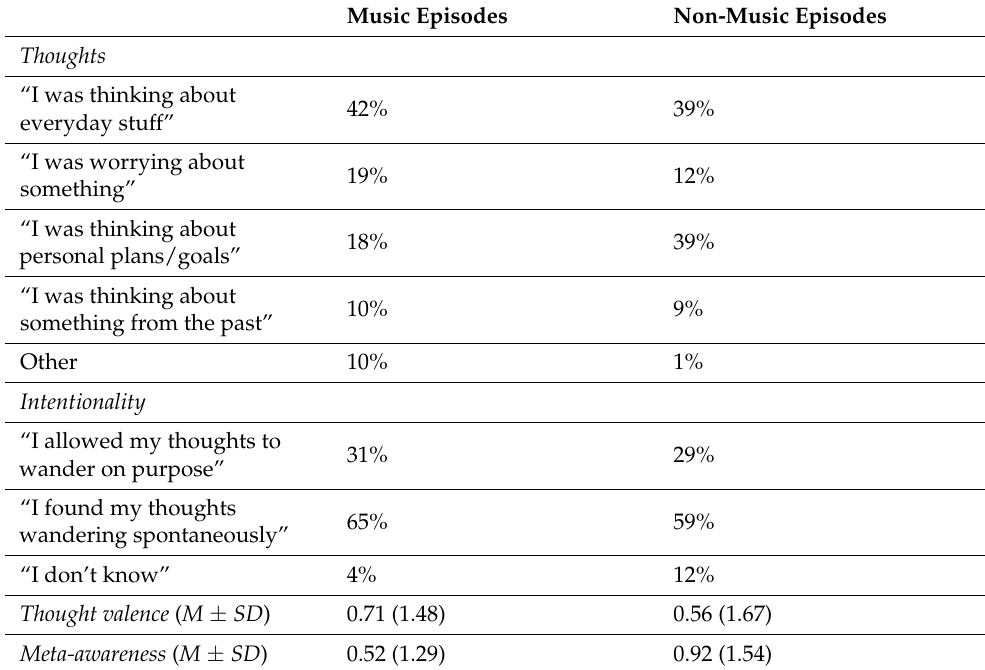
Table 3. Experiential characteristics of mind-wandering during music and non-music